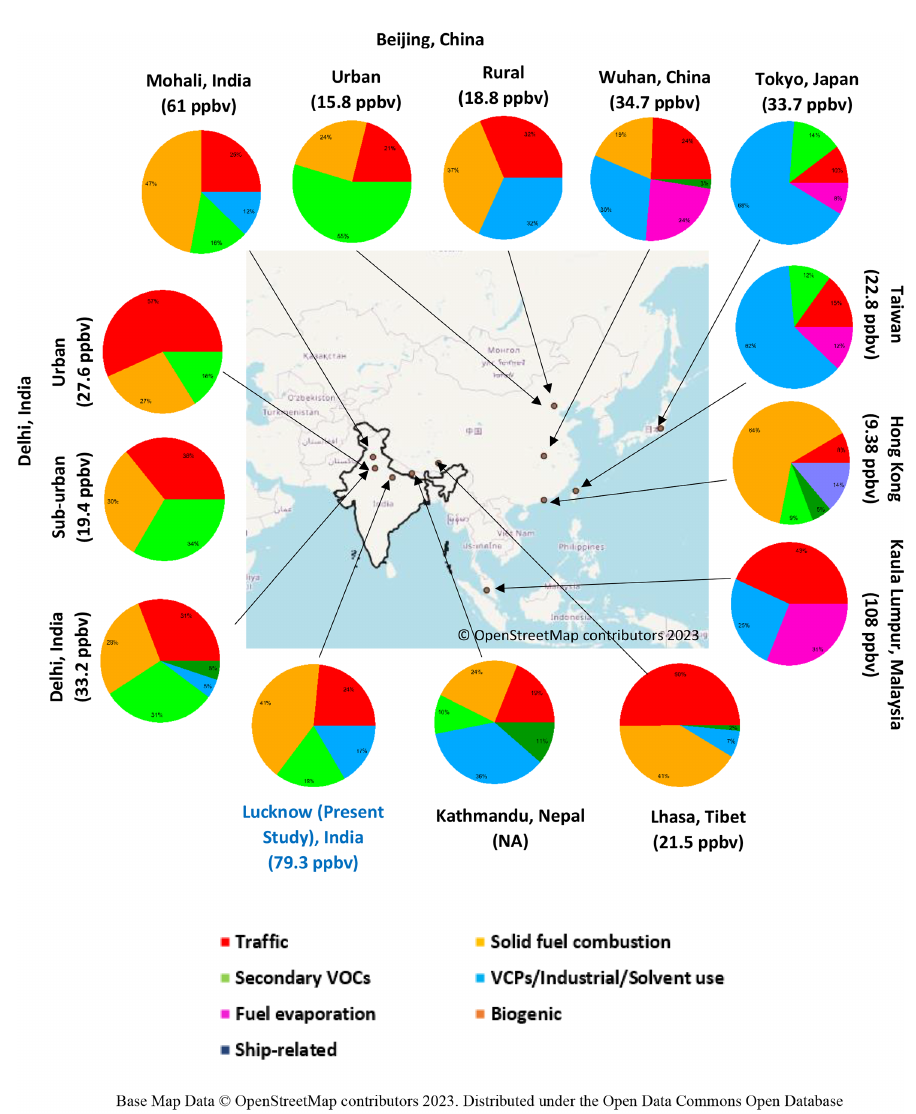
Figure 11. Mapped pie charts showing various sources of NMVOCs in different Asian and Indian cities. The bottom values (in brackets) rep- resent the averaged mixing ratios of total NMVOCs in the respective study. Base map data © OpenStreetMap contributors 2023. Distributed under the Open Data Commons Open Database License (ODbL)